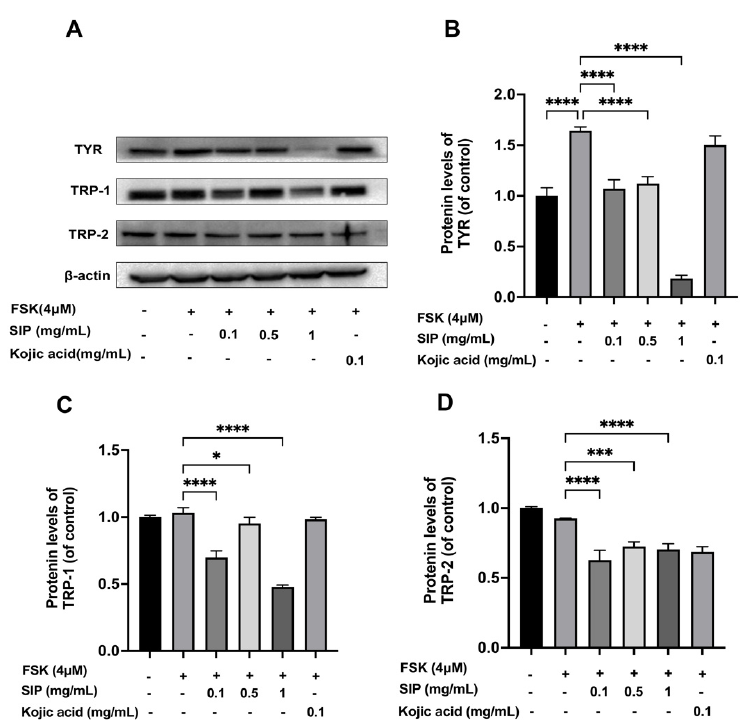
Figure 5. Effects of SIP on melanogenesis-related protein expression levels in FSK-stimulated B16F10 melanoma cells. ( A ) Protein expression levels of TYR, TRP-1, and TRP-2 were determined by Western blot following SIP treatment for 72 h with the indicated concentration. The densitometric analysis of TYR ( B ), TRP-1 ( C ), and TRP-2 ( D ) using Photoshop software2020 (Adobe, San Jose, CA, USA). Results were presented as mean ± SD. Statistical analysis was performed with one-way ANOVA, followed by Tukey’s multiple comparison test ( n = 3; * p < 0.05, *** p < 0.001, and **** p < 0.0001 compared with the forskolin-stimulated group).